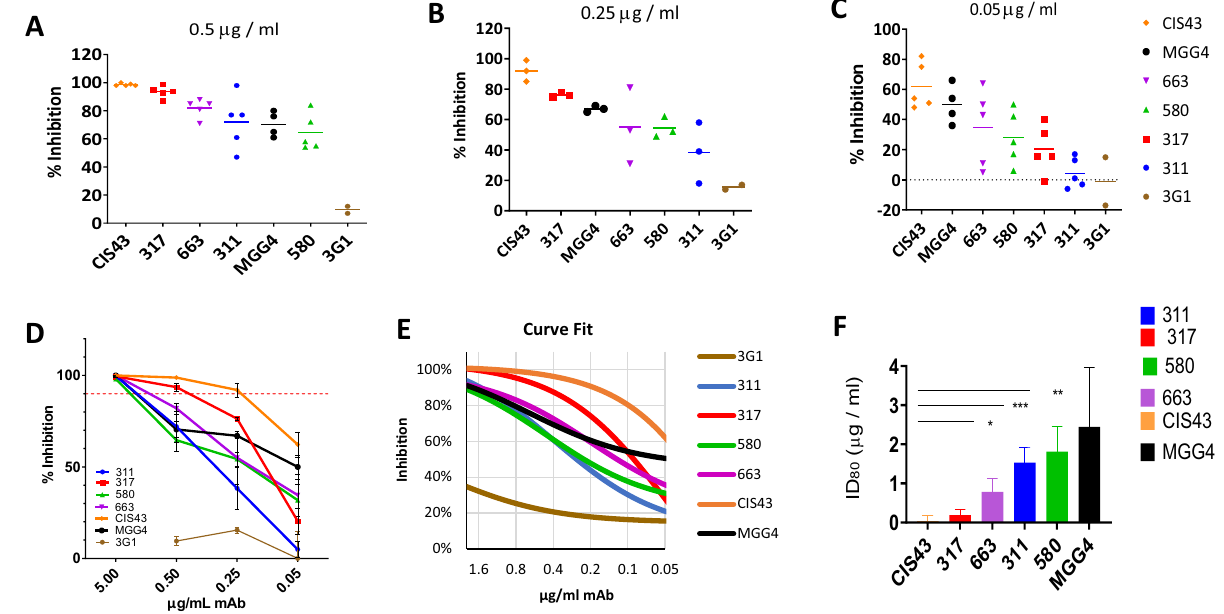
Figure 6. Inhibition of liver stage development assay (ILSDA). MAbs at varying dilutions were mixed with P. falciparum sporozoites (NF54 strain) and added to primary human hepatocytes. Hepatocyte invasion was quantified by RT-qPCR using a standard curve plotted using a pre-specified number of sporozoite mixed with the target cells. ( A – C ): Lines represent mean inhibition at ( A ) 0.5 µg/ml; (B) 0.25 µg/ml; ( C ) 0.05 µg/ml mAbs using data from three or more independent assays (symbols); negative control mAb 3G1 was run to show the effect of a non-specific mAb on sporozoite invasion. ( D ) Mean inhibition plotted against mAb concentrations (mean ± standard error) from 3 or more independent experiments; red line represents 80% inhibition. ( E ) Fitted inhibition curves used for the estimation of mAb dose required for 80% inhibition (ID 80 ). ( F ) Estimated ID 80 (mean + standard error) arranged in increasing order. Level of significance for pair-wise comparisons with mAb CIS43 are shown